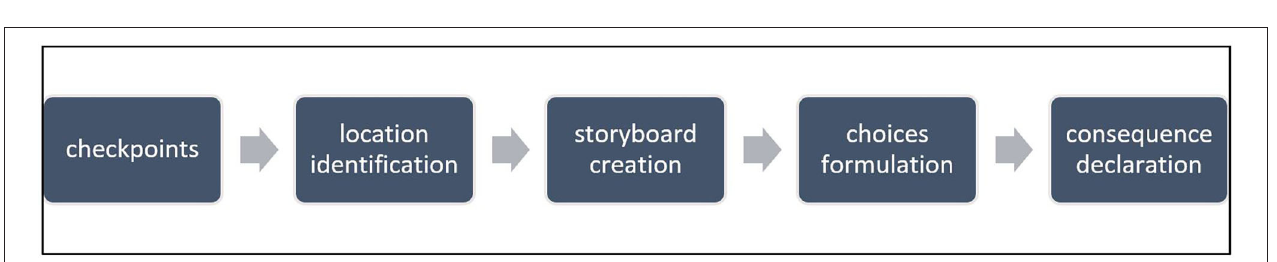
FIGURE 3 | Designing Challenges, Choices, and